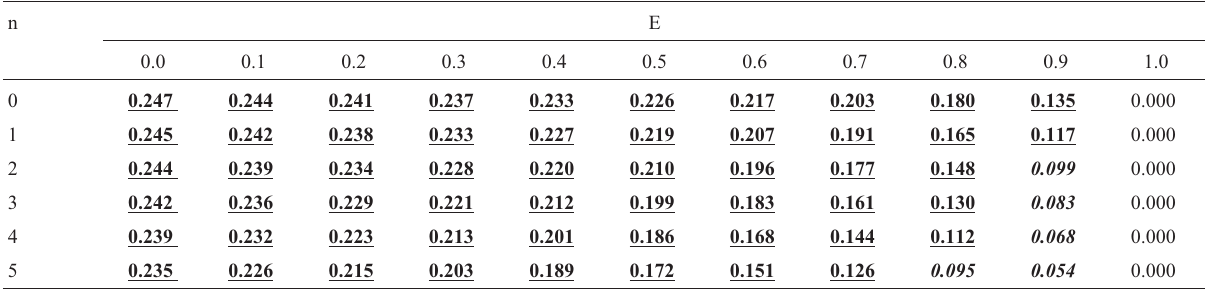
Table 4 - Recurrence risks for a sib of an isolated case, with consanguineous parents and F = 1/16 (first cousins, uncle-half-niece couples), in function of the rate of environmental cases (E) and of the number of normal sibs (n = n m + n f ) that the affected child already